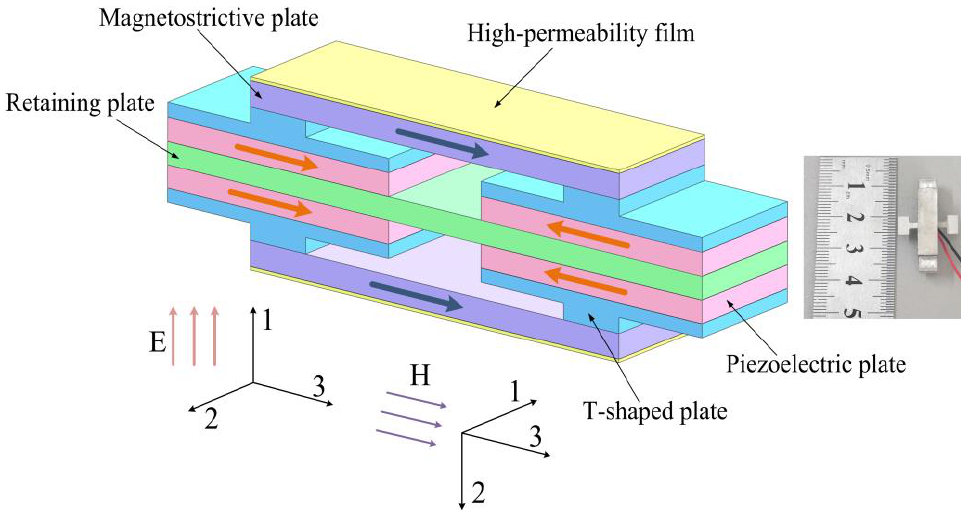
Figure 1. Schematic diagram and picture of the proposed shear-mode ME heterostructure.